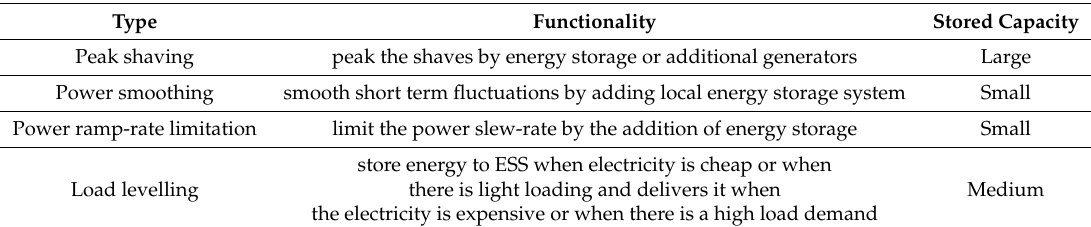
Table 5. Comparison between different applications of energy storage system (ESS).